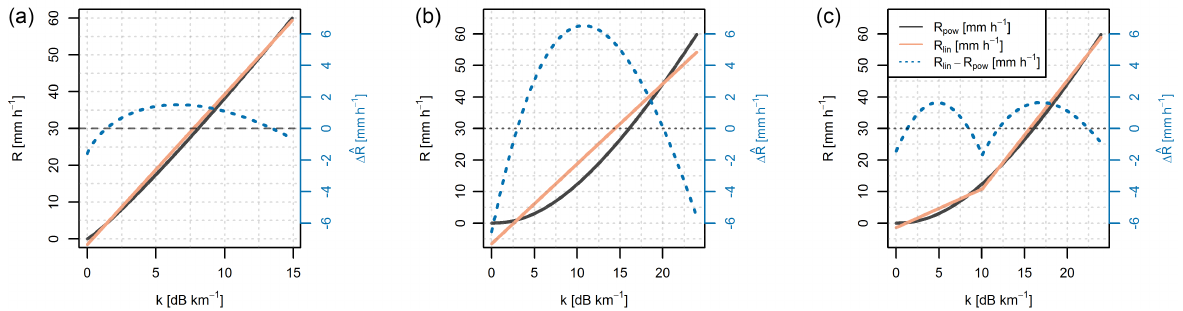
Figure 7. Performance of linear approximation of k – R models for vertically polarized 38GHz CML in terms of rainfall intensity. Left panel: linear approximation (red) of the power-law model (black). The blue dashed line shows the resulting model structure errors. Middle panel: linear approximation of power-law model coupled with Kharadly’s wet antenna attenuation model. Right panel: power-law model combined with Kharadly’s wet antenna attenuation model approximated by two linear models fitted separately for light ( R ≤ 12mmh − 1 ) and heavy rainfall events ( R > 12mmh − 1